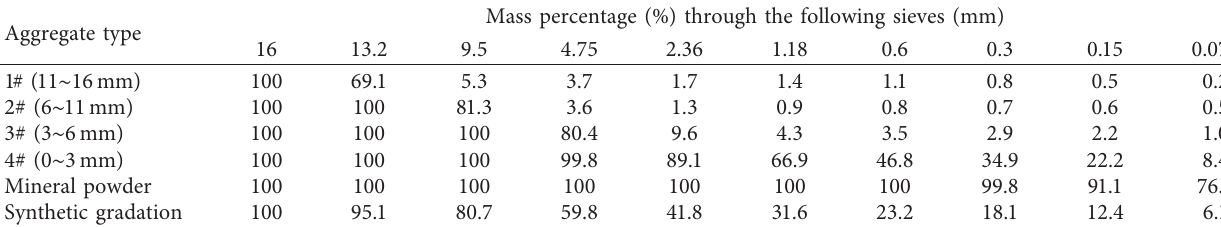
Table 1: Asphalt mixture aggregate gradation design.